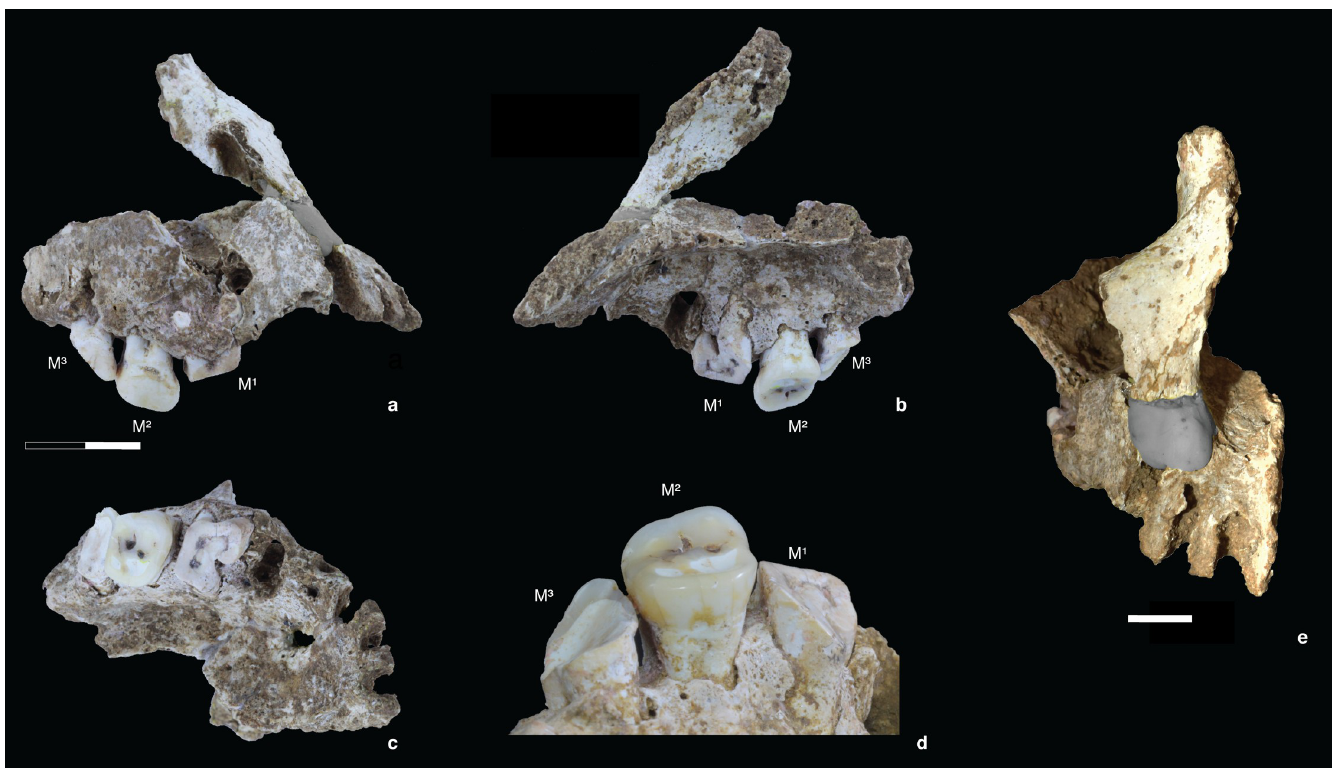
Fig 6. Right maxilla and frontal process (Maros-LBB-1a) from Layer 4a at Leang Bulu Bettue. (a-b) right and left lateral views of the right maxilla (after reconstruction). The small point of contact between the dental portion and nasal pillar is obscured by glue and plasticine; (c) inferior view of the right palate; (d) detail of the lingual sides of the extant first to third right upper molars (M 1 to M 3 ), showing the extreme degree of occlusal attrition on the M 1 and M 3 . The M 1 had lost its crown by extreme wear and there are abscess cavities around the root tips, owing to the exposure of dental pulp cavities. The M 3 retains its enamel only at the mesiobuccal corner. Only the M 2 has a normal occlusal plane. The M 2 still retains much of its occlusal enamel but is considerably over-erupted, suggesting that its opposing tooth (M 2 ) had been lost while the individual was alive; (e) anterior view of the reconstruction of the right maxilla and frontal process. The scale in (a-c) is in 10 mm increments; in (e) the scale bar is 10 mm. Photo credits: Ratno Sardi (a-d); David Bulbeck